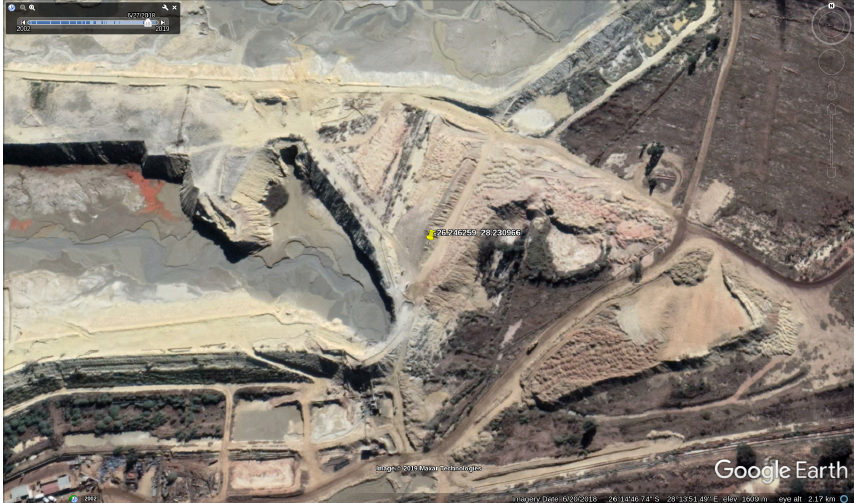
Figure 13. Google Earth image of at a tailings mine dump retreatment site.